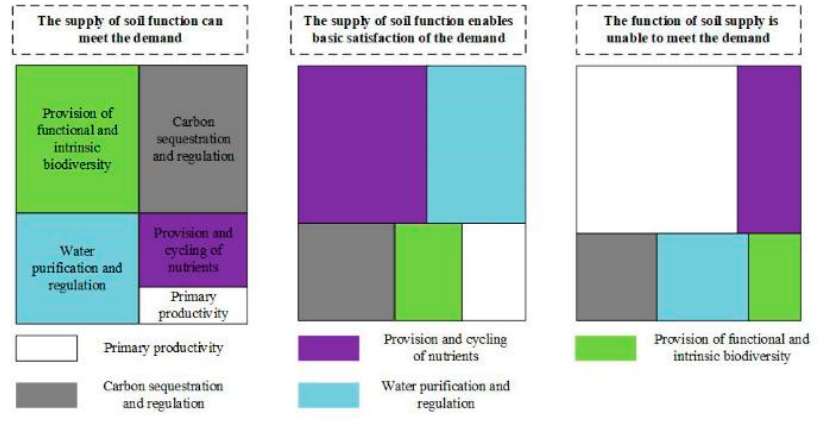
Figure 11. Proportion of supply and demand area of cultivated land soil function.